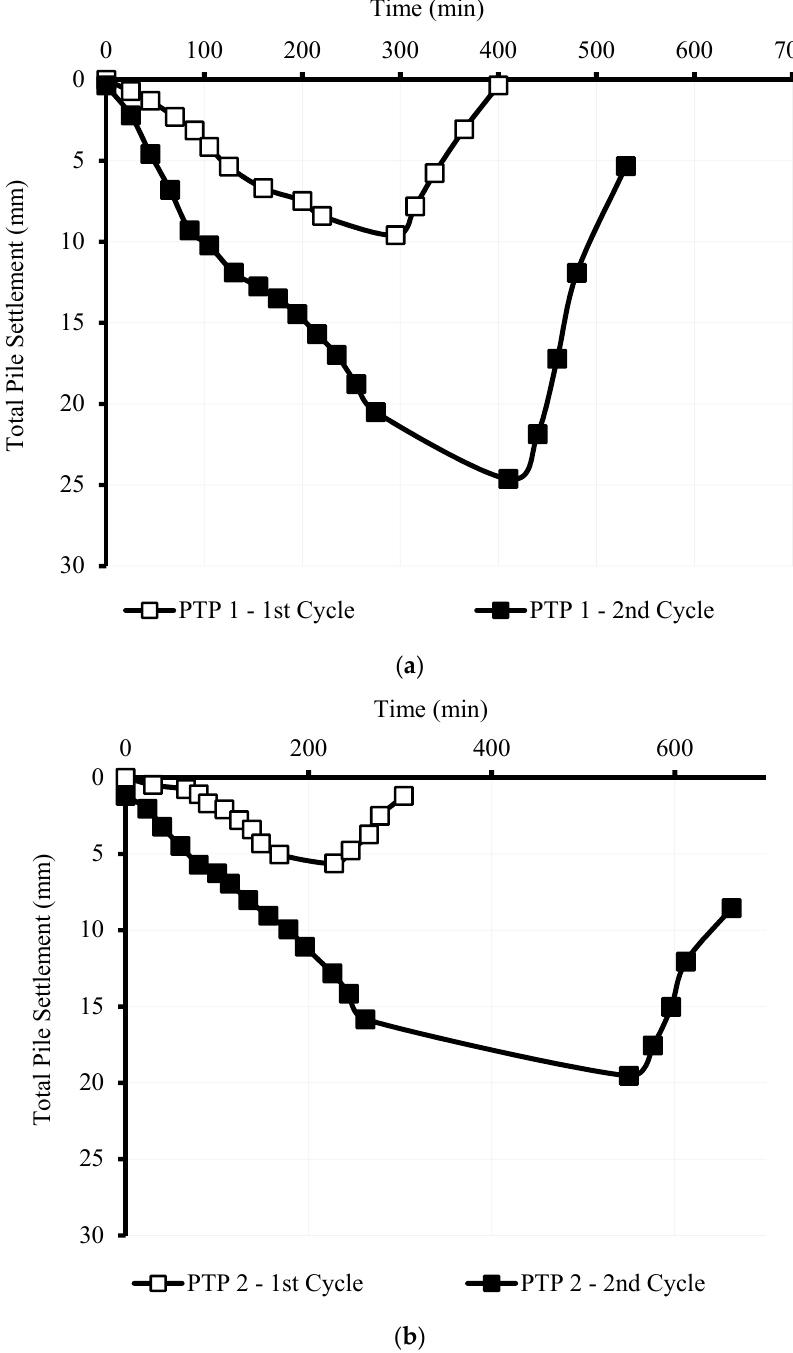
Figure 20. Variation of the total pile settlement versus time during pile test in ( a ) BP# 1 and ( b ) BP# 2.